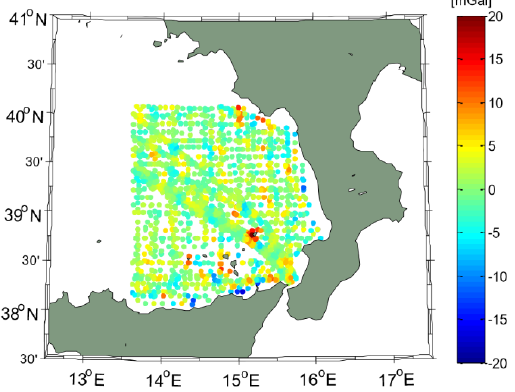
Fig. 5. Difference of LARS altimetric gravity anomalies and EGM2008 over the shipborne survey locations. In total, 2264 samples.